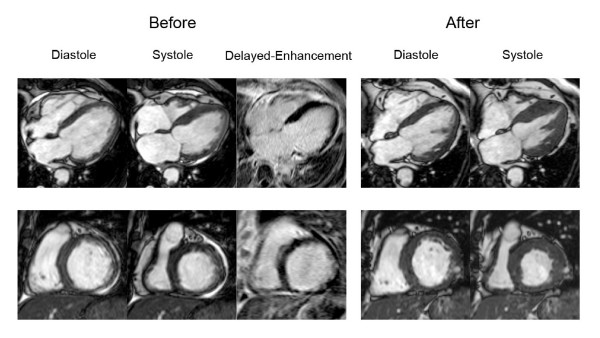
End-diastolic, end-systolic and LGE images before CABG and end-diastolic and end-systolic images after CABG of a patient with wall thinning and LGE area 1–25% in inferolateral wall displayed in 4-chamber (upper) and short-axis (lower) views.